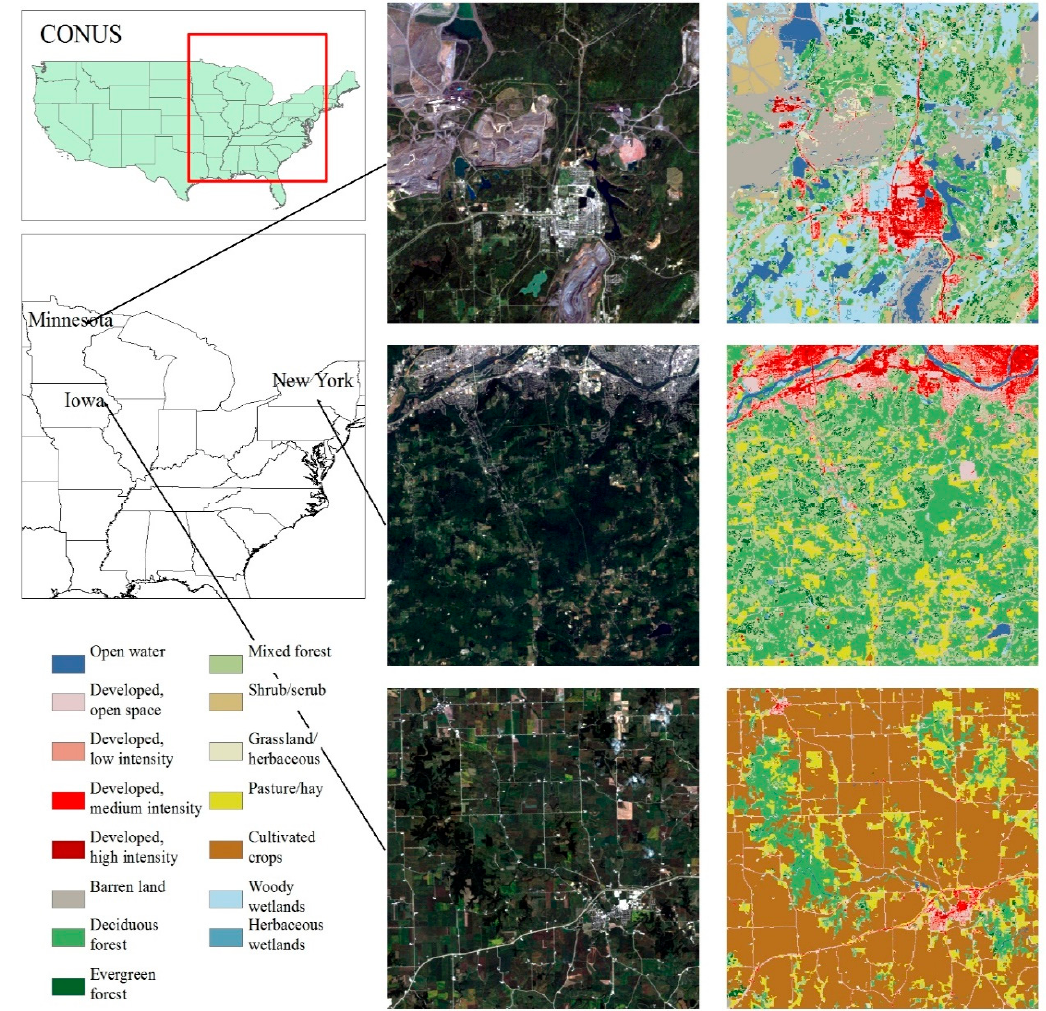
Figure 1. Illustration of the 2011 Landsat TM (middle column) and National Land Cover Database (NLCD) (right column) data of the three study areas. A subset of the full Landsat scenes was taken to form each study area. The Landsat images are displayed as 3-2-1 TM band combinations. Landsat data of Minnesota, Iowa, and New York study area were acquired on 11 September, 13 September, and 21 July, respectively. Maps in the upper left corner show the location of the three study areas in the United States.